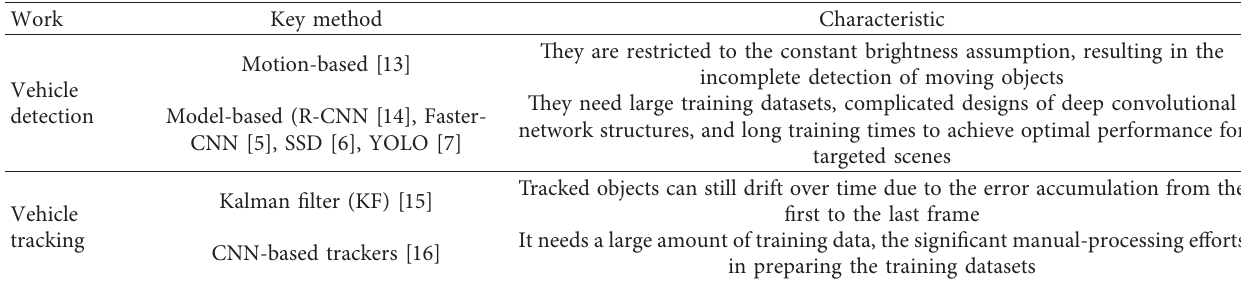
Table 1: Video-based vehicle trajectory extraction